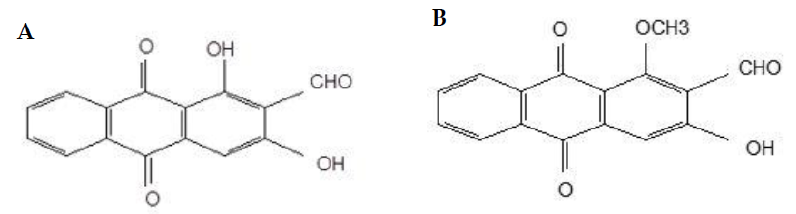
Figure 1. Chemical structure of nordamnacanthal ( A ) and damnacanthal ( B